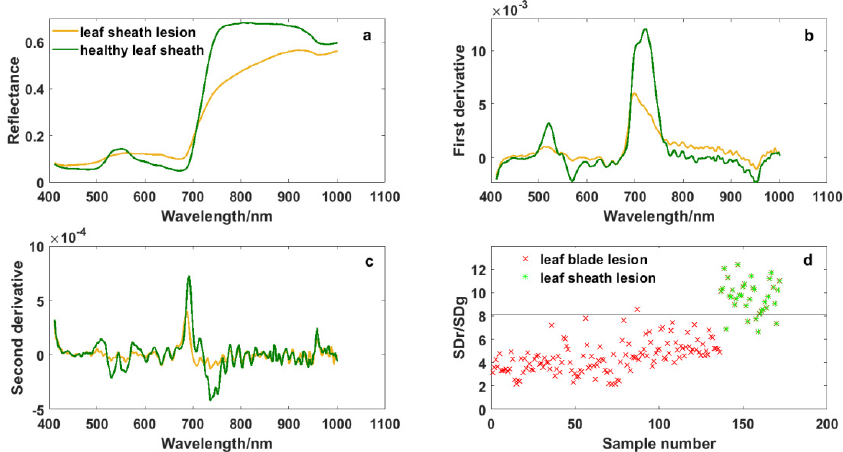
Figure 6. Spectral curves of leaf sheath lesions and the variable SDr / SDg: ( a ) Original spectrum, ( b ) first derivative transformation spectrum, ( c ) second derivative transformation spectrum, and ( d ) the ability of SDr / SDg to distinguish the leaf sheath lesions from the leaf blade lesions.